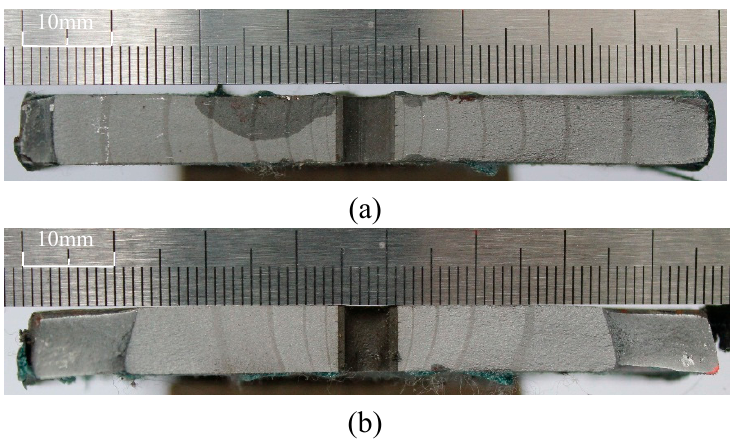
Figure 6. ( a ) Fracture surface of specimen ND-2 (double-sided strengthening); ( b ) Fracture surface of specimen NS-2 (single-sided strengthening).